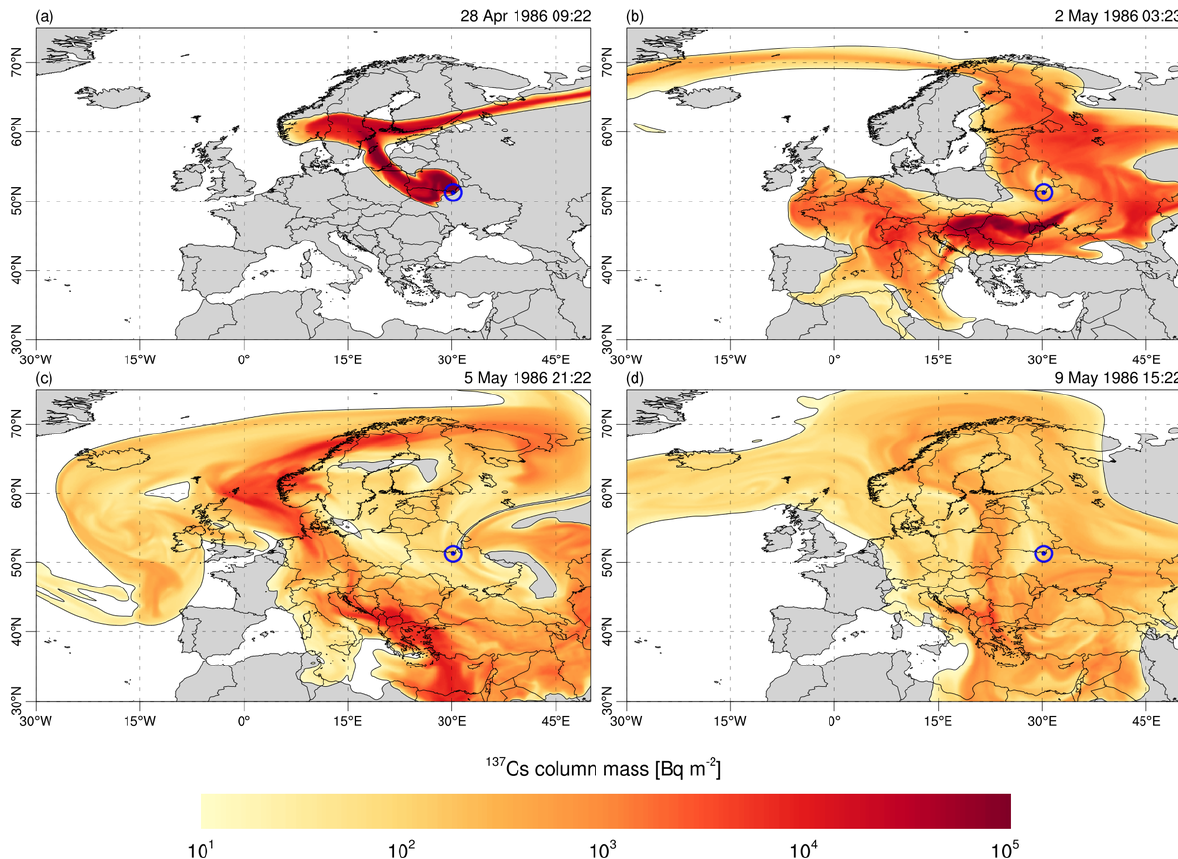
Figure 10. Vertically integrated 137 Cs radioactivity concentration in the atmosphere at different times according to Chernobyl-1986 test results: (a) 28 April 1986, (b) 2 May 1986, (c) 5 May 1986 and (d) 9 May 1986. The underlying maps are reported just for reference and could contain nations’ borders that are under